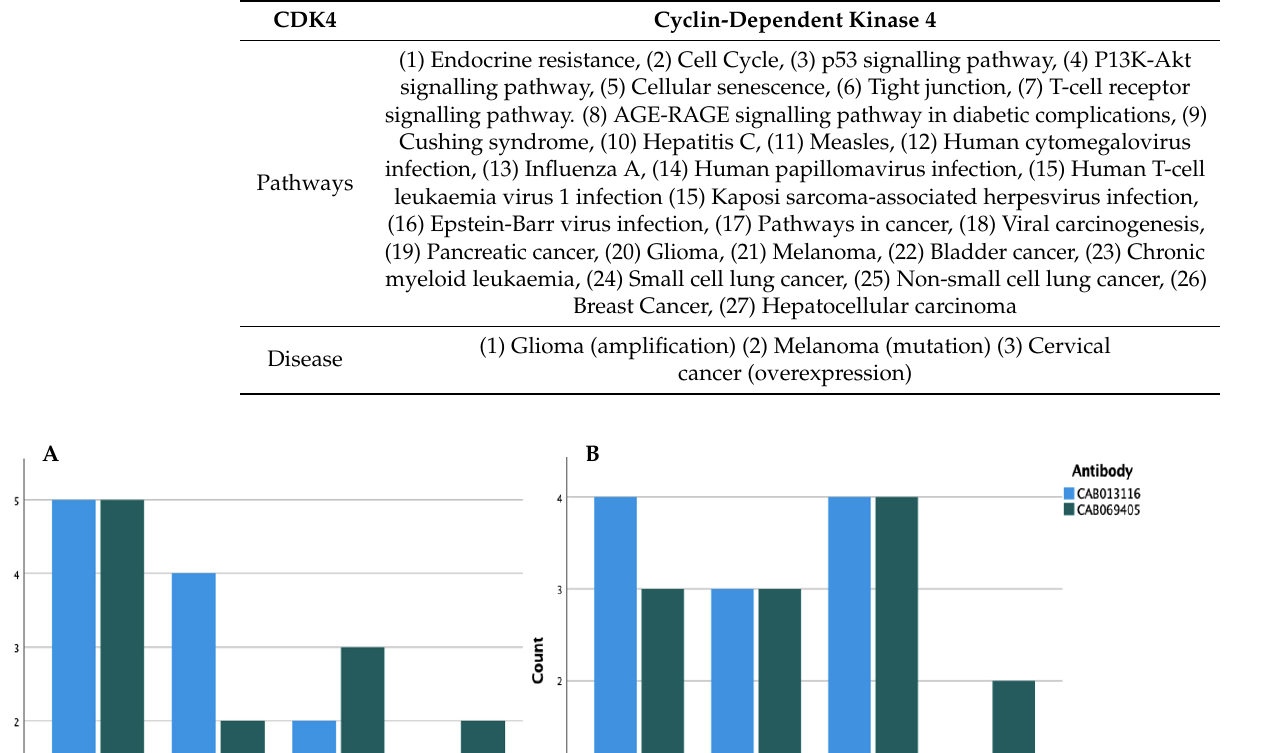
Table 4. A list of biological pathways and diseases that CDK4 is involved in, as obtained from the Kyoto Encylopedia of Genes and Genomes (KEGG) PATHWAY database (Kyoto, Japan).